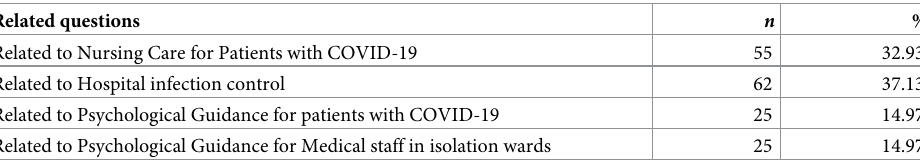
Table 5. The issues raised on the telemedicine Q&A platform (n =